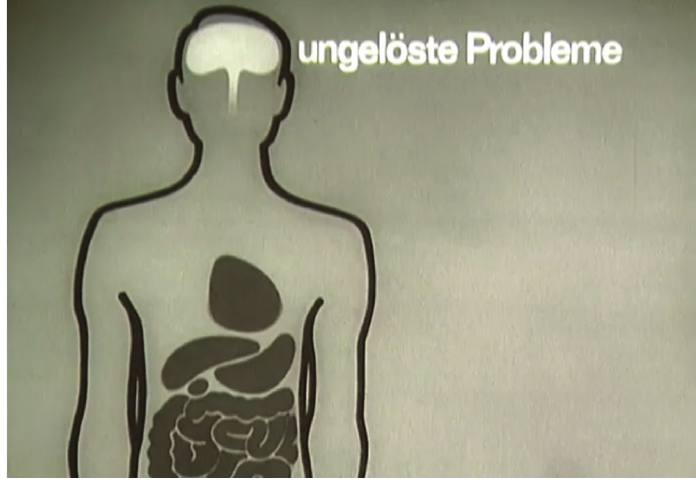
feedback loop. Emotions are visualized as bad vibes that make the transmitter a “disturbing factor” in social interactions, and then trigger new bad vibes in return. “Every person giving off tension becomes a disturbing factor in interpersonal relationships. It’s bad when leaders themselves become a disturbing factor. It impairs mutually